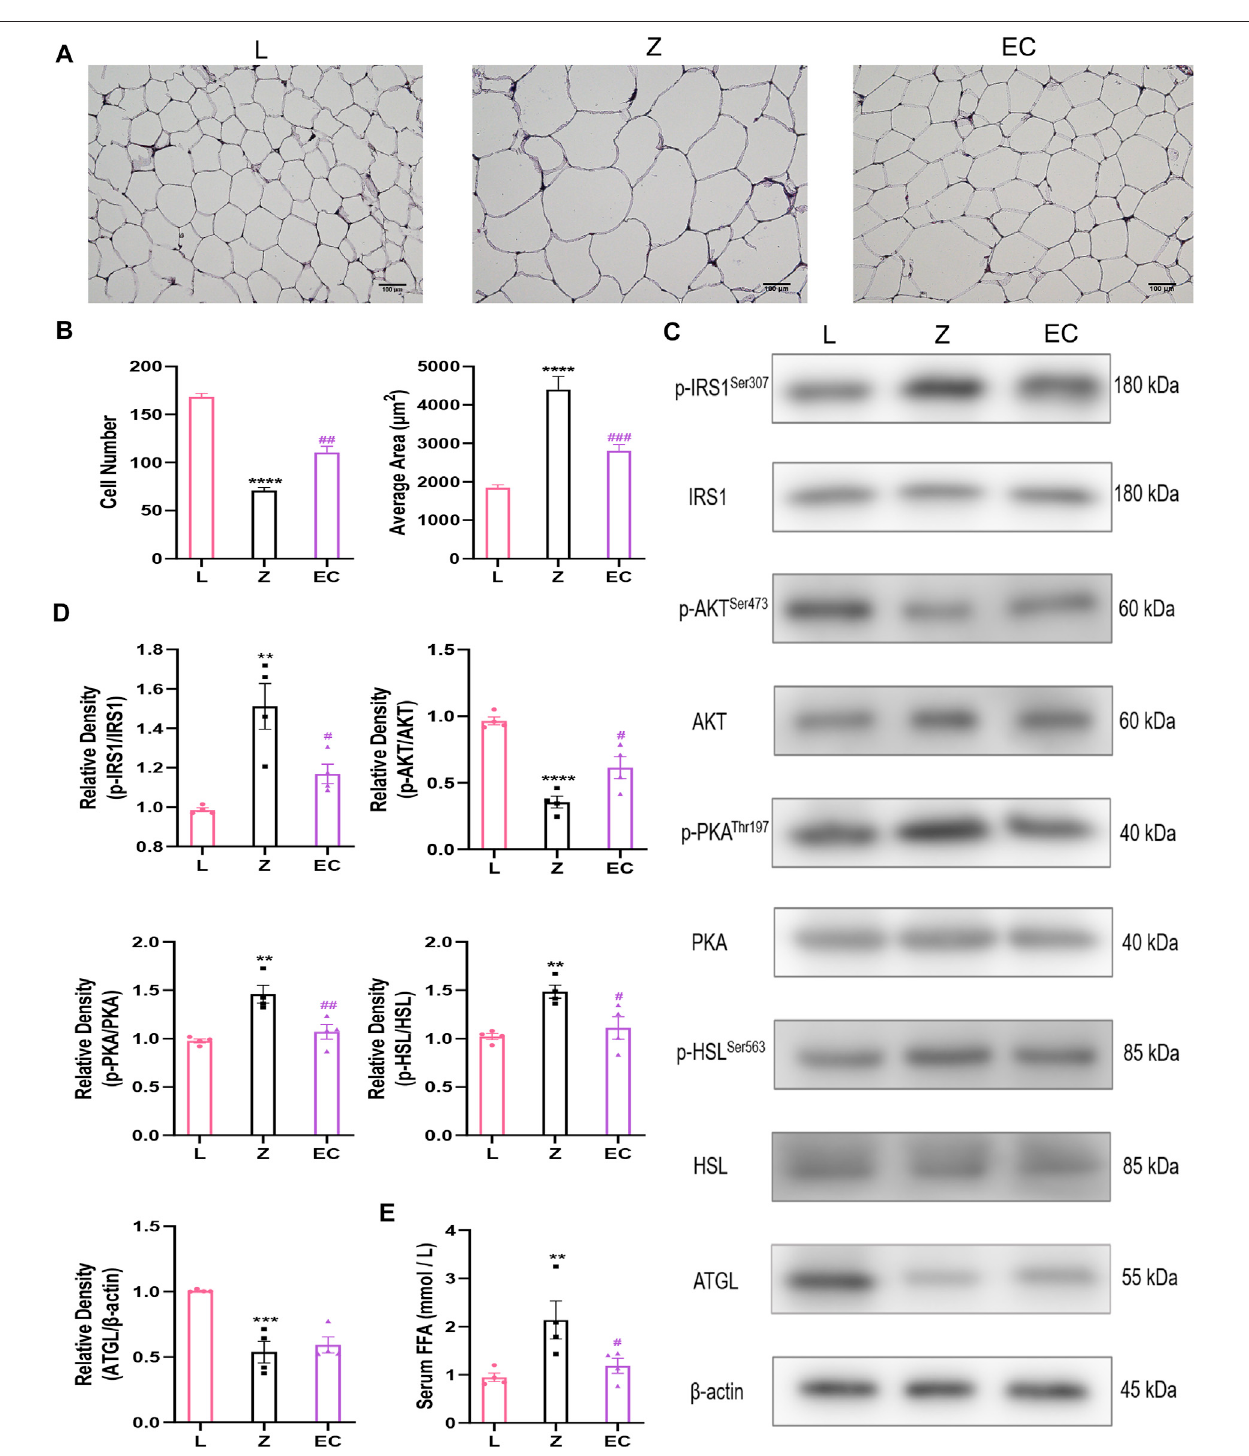
FIGURE 3 | ECD improved insulin signal transduction and decreased lipolysis in WAT of ZDF rats. (A) Representative image (bar: 100 µM) and (B) number and average area of adipocytes of WAT HE staining ( n (cid:2) 3. Z vs. L, **** p < 0.0001; EC vs. Z, ## p < 0.01, ### p < 0.001). (C) Representative bands and ( D ) relative protein expression of p-IRS1/IRS1, p-AKT/AKT, p-PKA/PKA, p-HSL/HSL, and ATGL. (E) Serum FFA concentration ( n (cid:2) 4. Z vs. L, ** p < 0.01, *** p < 0.001, **** p < 0.0001; EC vs. Z, # p < 0.05, ## p < 0.01). (B), (D), and (E) were analyzed by one-way ANOVA.